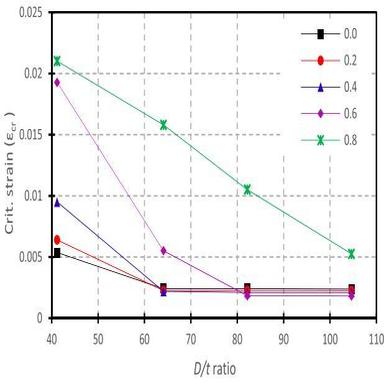
Plot of εcr vs. D/t ratio for X70 pipe (YPL = 1.25). Fig. 13. Plot of εcr vs. D/t ratio for X70 pipe (YPL = 2.0).